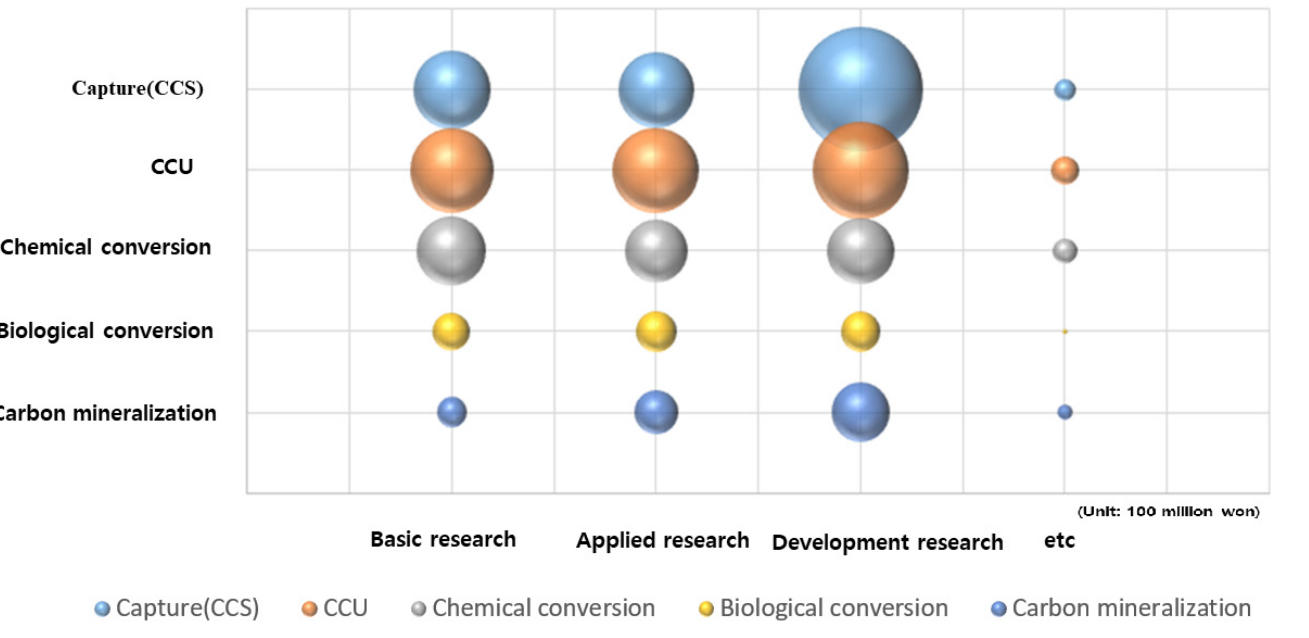
Figure 8. R&D investment for each of the research stages in major CCUS sub-sections in Korea from 2011 to 2020 (data from MSIT, 2021).